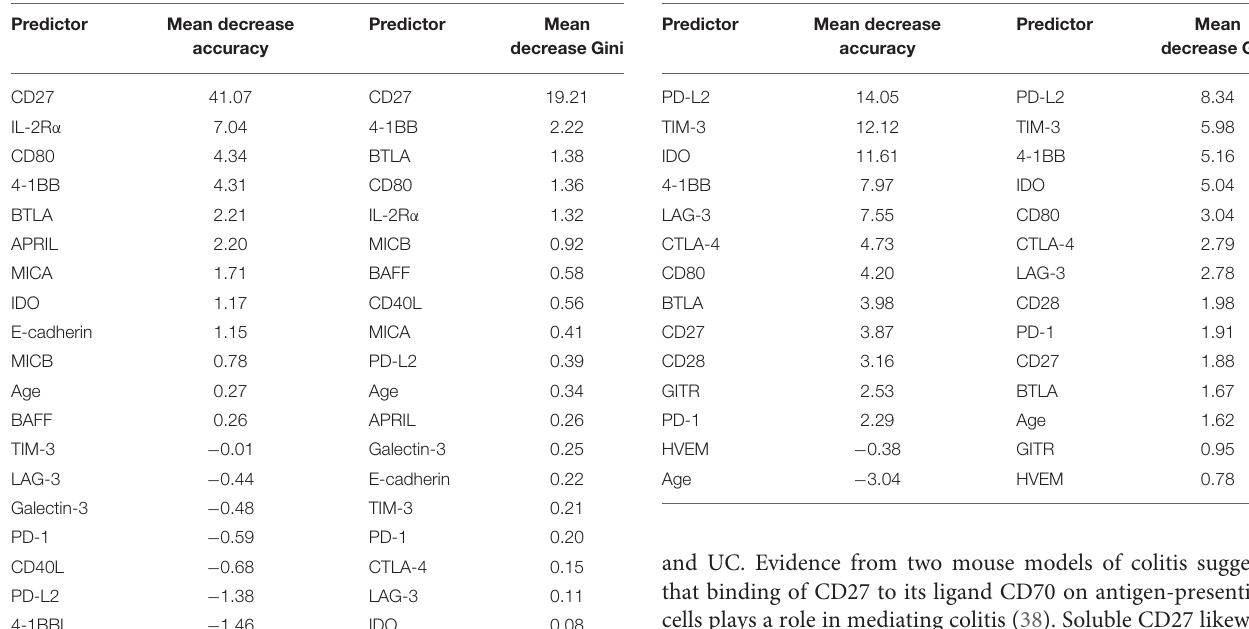
TABLE 8 | Summary of predictors (analytes) with the highest variable importance in biopsies, assessed both in terms of mean decrease in accuracy and mean decrease in in Gini